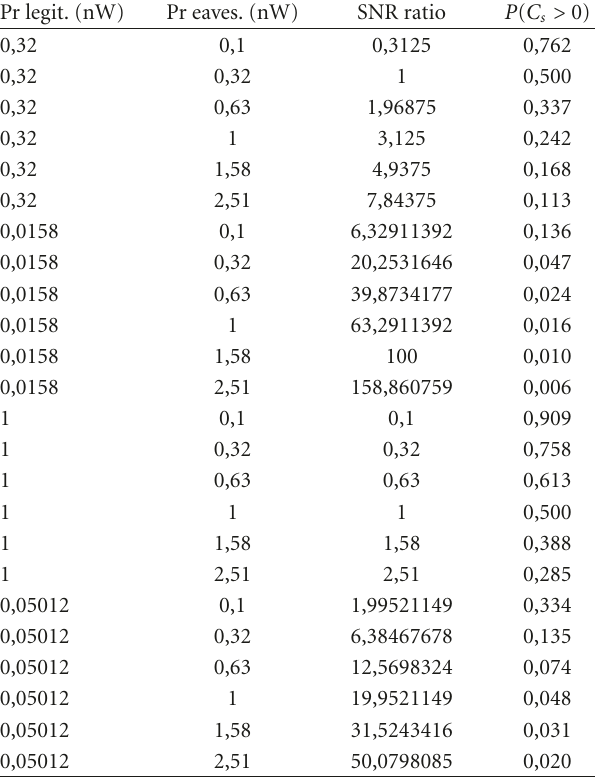
Table 4: P ( C s > 0) for OLOS-2 (T4) scheme.